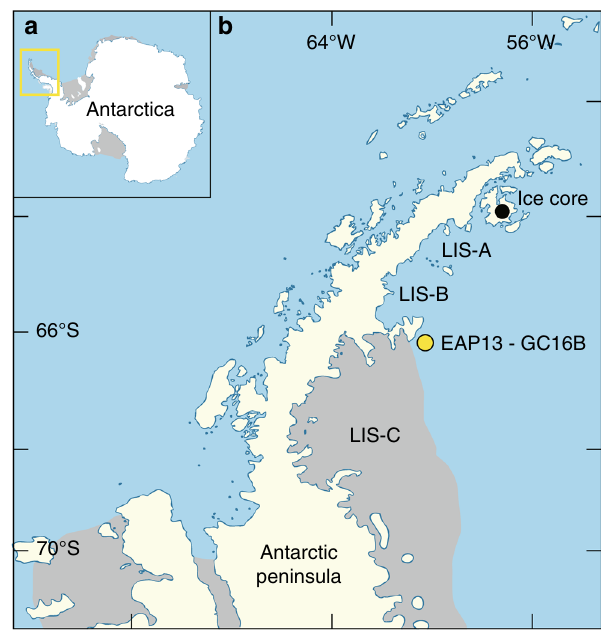
Fig. 1 Location map of study area in Antarctica. a Study area (yellow box) along the northern Antarctic Peninsula. b EAP13-GC16B sediment core collected from Larsen ice shelf C (LIS-C) embayment. Ice core drilling site 7 , James Ross Island is north of Larsen ice shelves A (LIS-A) and B